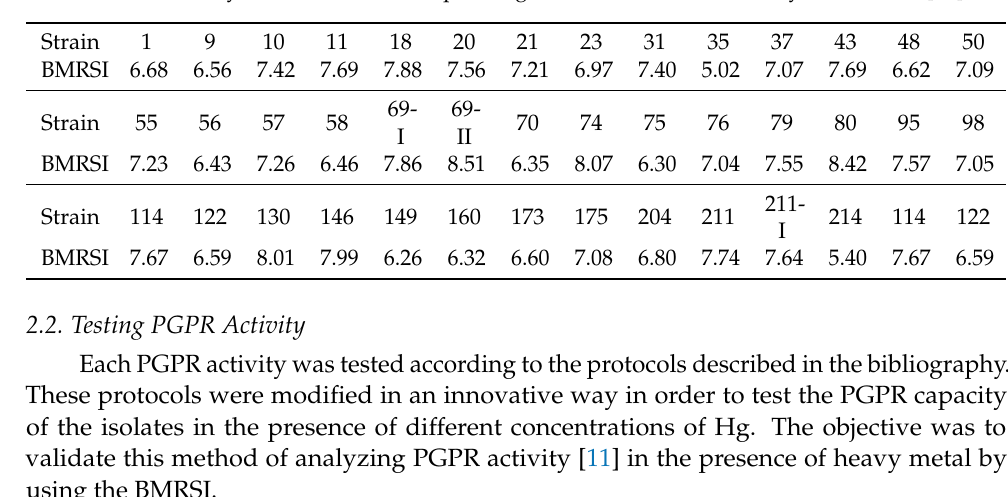
Table 1. Strains analyzed with their corresponding BMRSI values, obtained by Robas et al. [11]. Strain